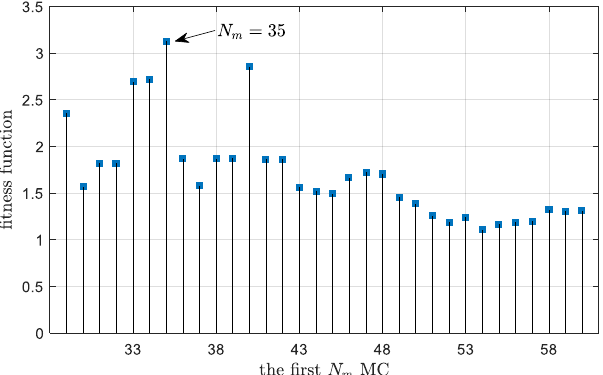
Figure 7. Fitness function of damage case A at a 3% level of noise, for the ITR method.